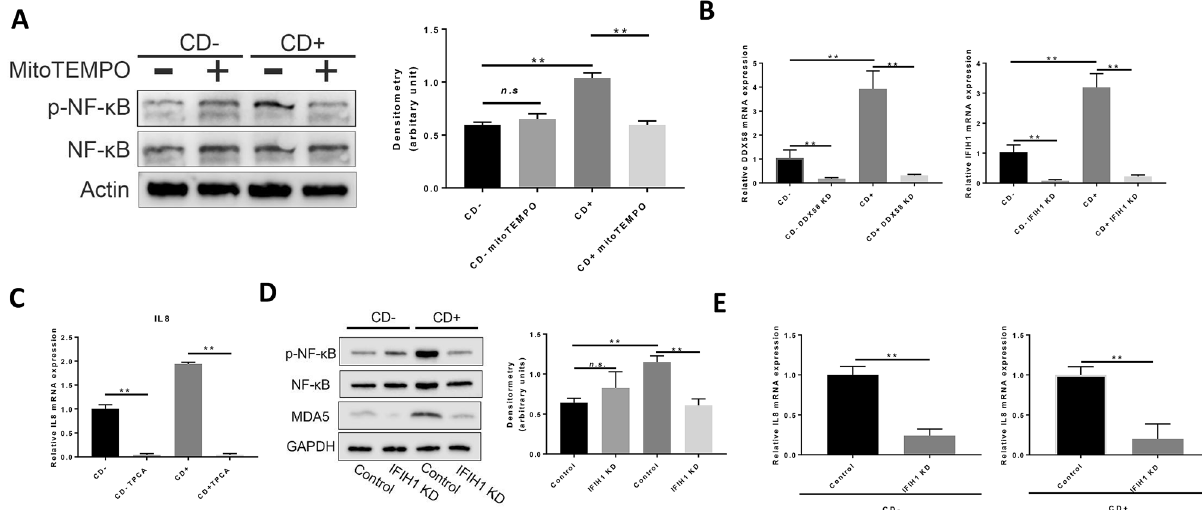
Figure 2. MDA5 signaling induces IL-8 upregulation via NF-κB phosphorylation in CD+ keratocytes. ( A ) Western blot of NF-κB phosphorylation in CD− and CD+ keratocytes with/without mitoTEMPO ( n = 4). NF-κB and p-NF-κB were blotted and cropped from the same gel. p-NF-κB was blotted first and the membrane was stripped and washed for NF-κB blotting. Actin was blotted separately from a different gel using the corresponding samples. Exposures were adjusted automatically by the Odyssey Fc imaging system. ( B ) DDX58 and IFIH1 mRNA expression in CD+/− keratocytes 48 h after respective siRNA transfection ( n = 3). ( C ) IL-8 mRNA expression in keratocytes 24 h after 20 nM TPCA treatment ( n = 3). ( D ) NF-κB phosphorylation, analyzed by western blot, after IFIH1 knock-down in CD+/− keratocytes ( n = 3). NF-κB and p-NF-κB were blotted and cropped from the same gel. p-NF-κB was blotted first and the membrane was stripped and washed for NF-κB blotting. GAPDH and MDA5 were blotted separately from a different gel using the corresponding samples. Exposures were adjusted automatically by the Odyssey Fc imaging system. ( E ) IL-8 mRNA expression in CD+/− keratocytes after IFIH1 knockdown by siRNA transfection ( n = 3). Values are means ± SD. n.s. (not significant); *P < 0.05, **P <